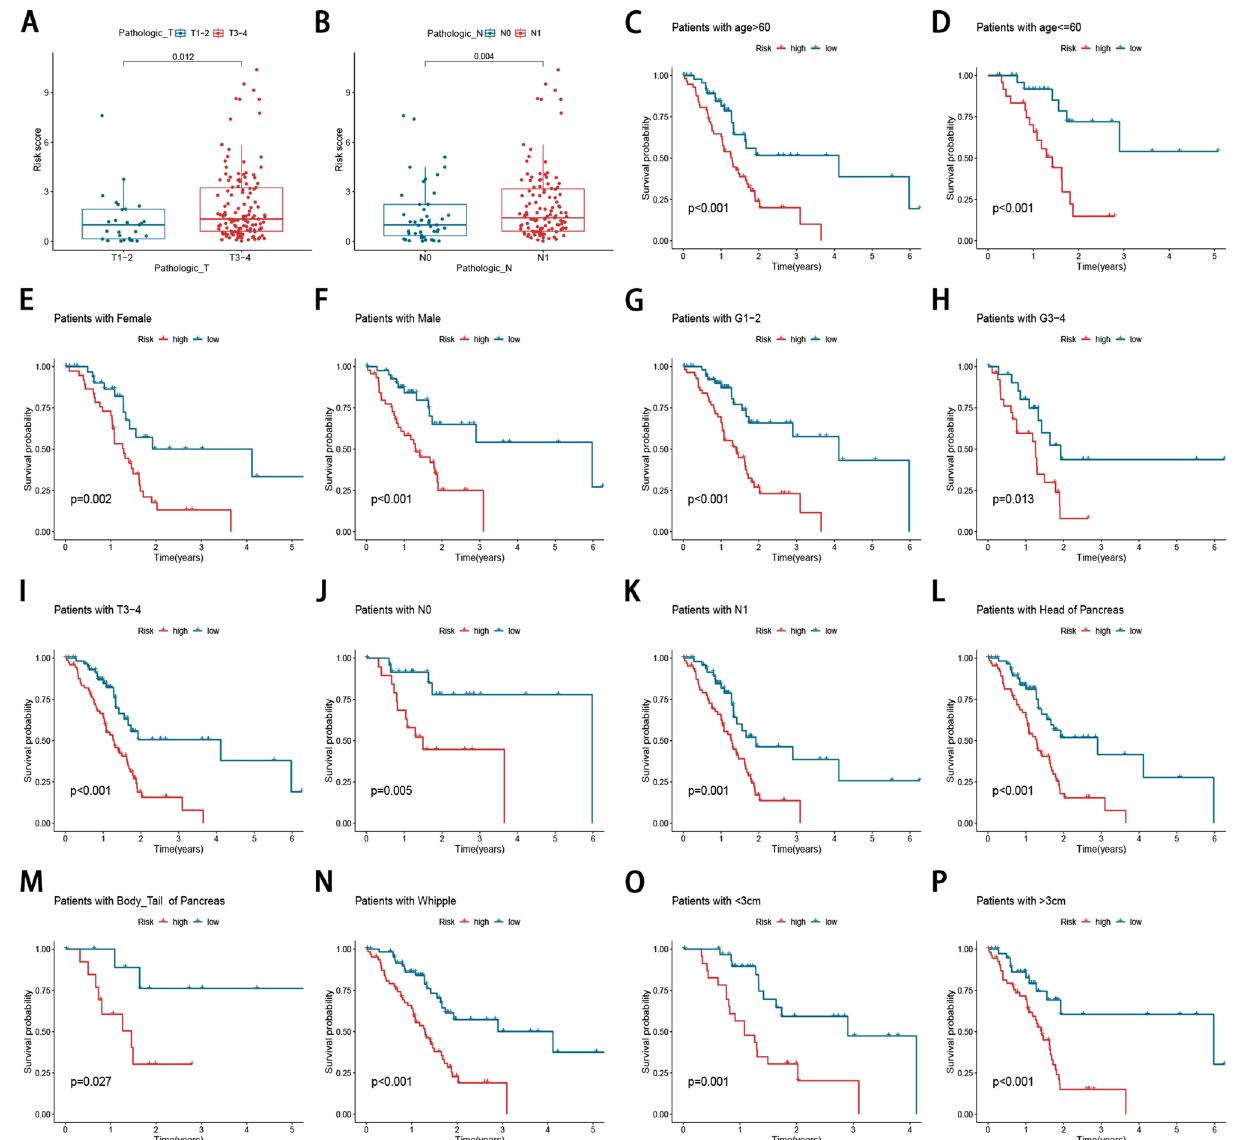
Figure 5. Clinical correlation analysis and stratification analysis of signature. ( A ) Correlation between the risk score and T stage. ( B ) Correlation between the risk score and N stage. ( C – P ) Stratified survival analysis between the high- and low-risk